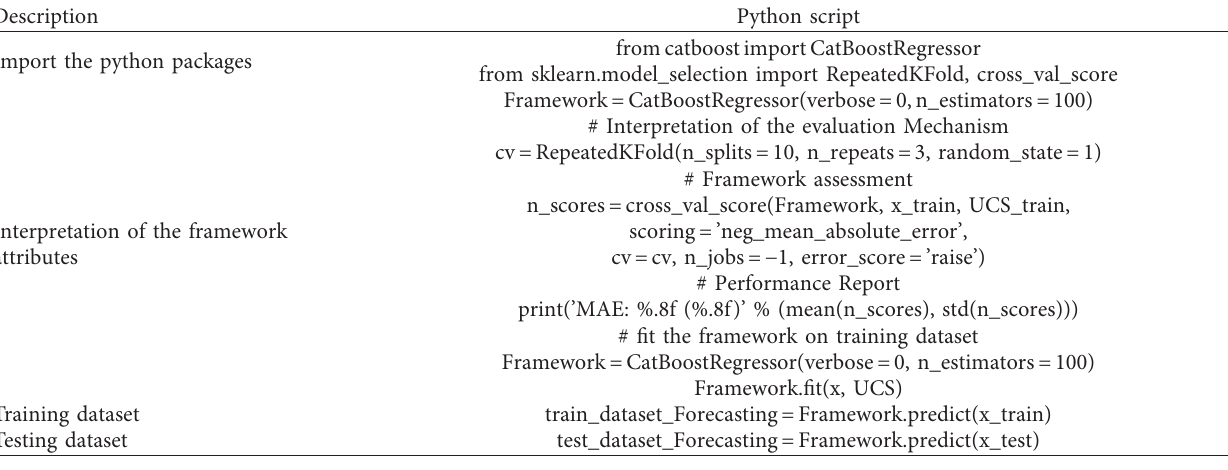
Table 5: Executing a catboost framework in python employing the catboost